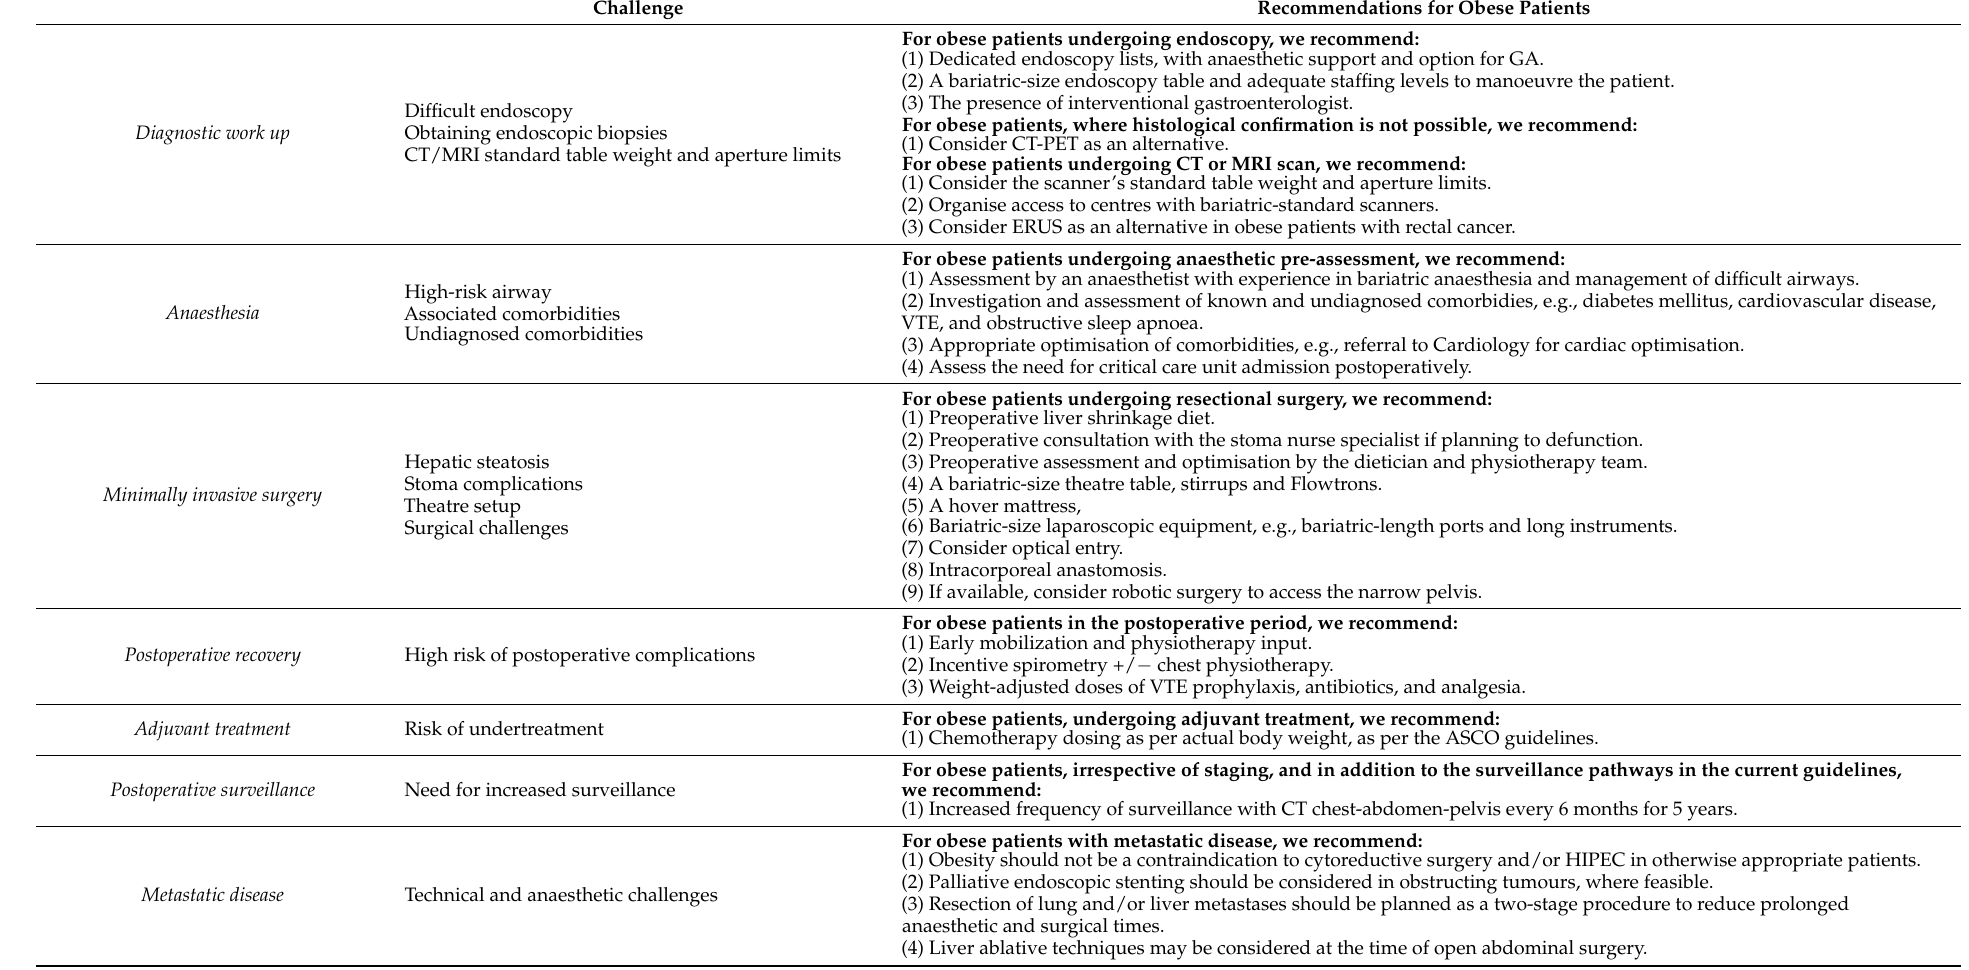
Table 10. Recommendations for obese patients with colorectal